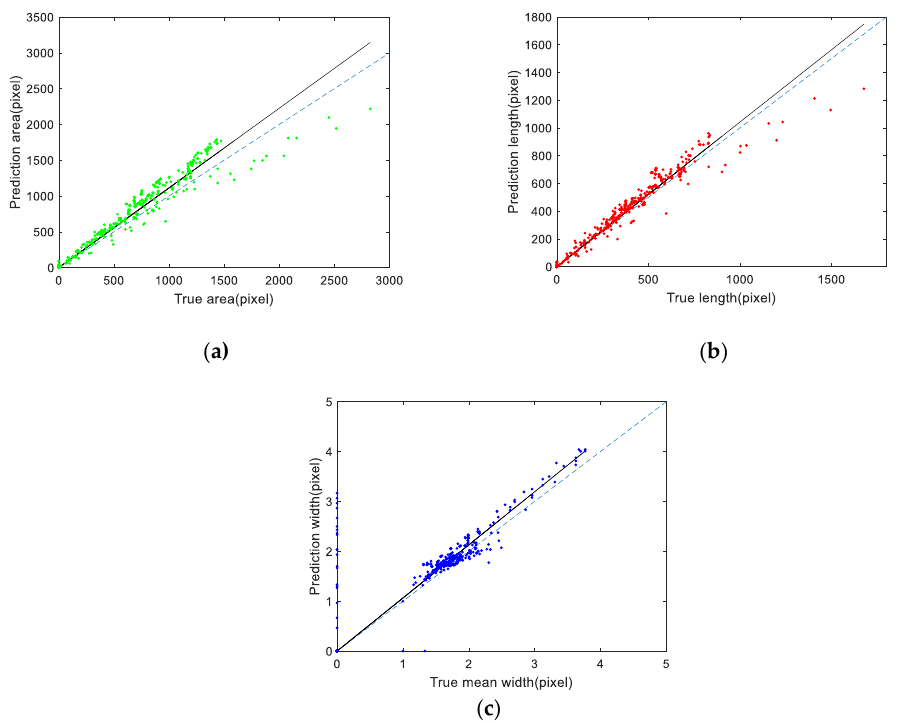
Figure 12. Scatter diagrams of crack measurement using U-CliqueNet: ( a ) crack area, ( b ) crack length, ( c ) crack mean width.